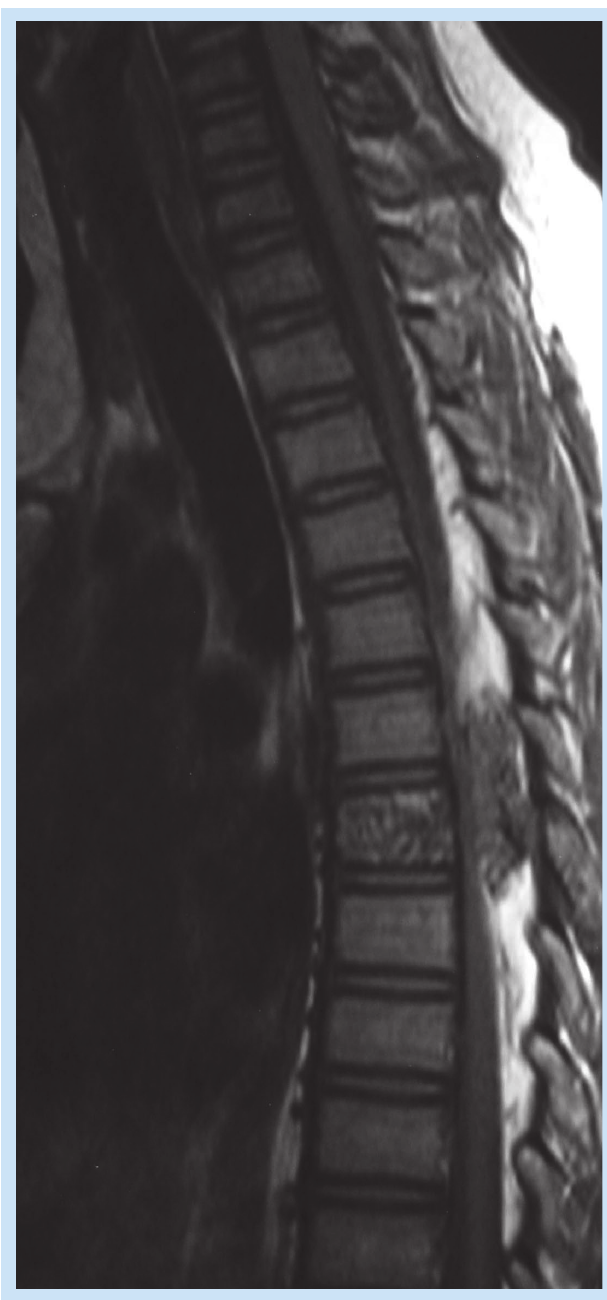
Fig. 4. A 10-year-old boy with capillary haemangioma of the vertebral body. Sagittal T1-weighted image shows a mottled pattern of increased intensity with a large extradural component.